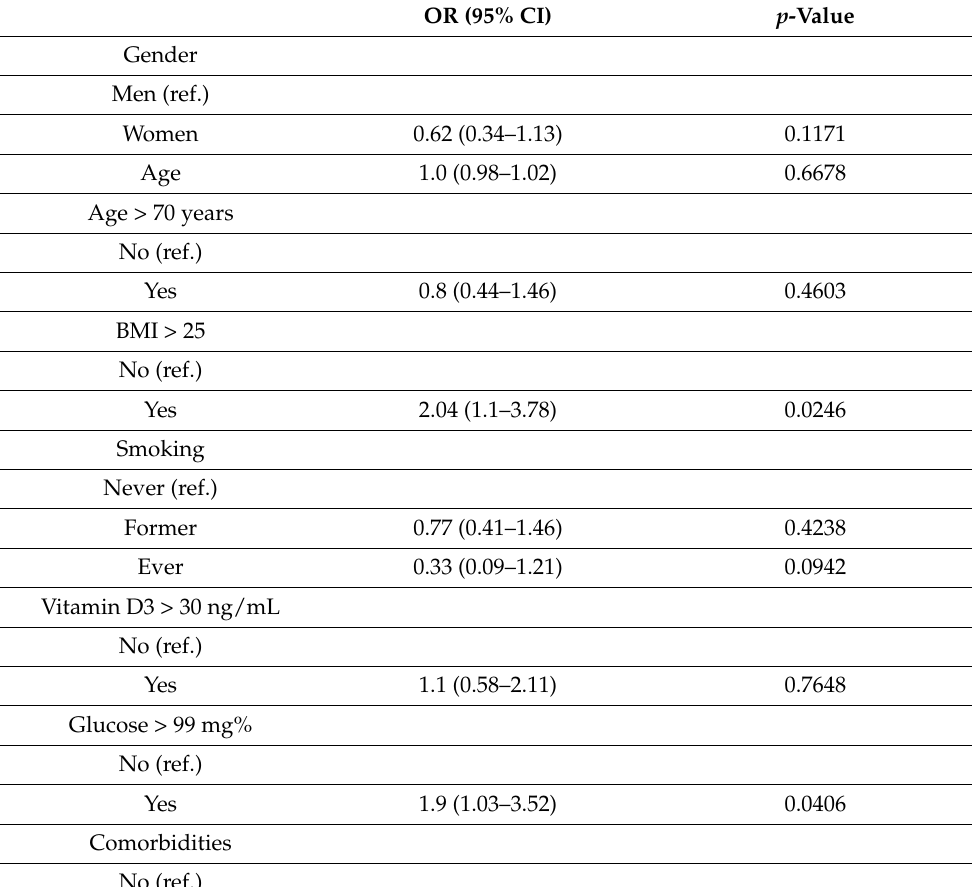
Table 4. Logistic regression analysis of the risk factors of mild to severe COVID-19 in the entire cohort of individuals developing COVID-19 (vaccinated and unvaccinated).